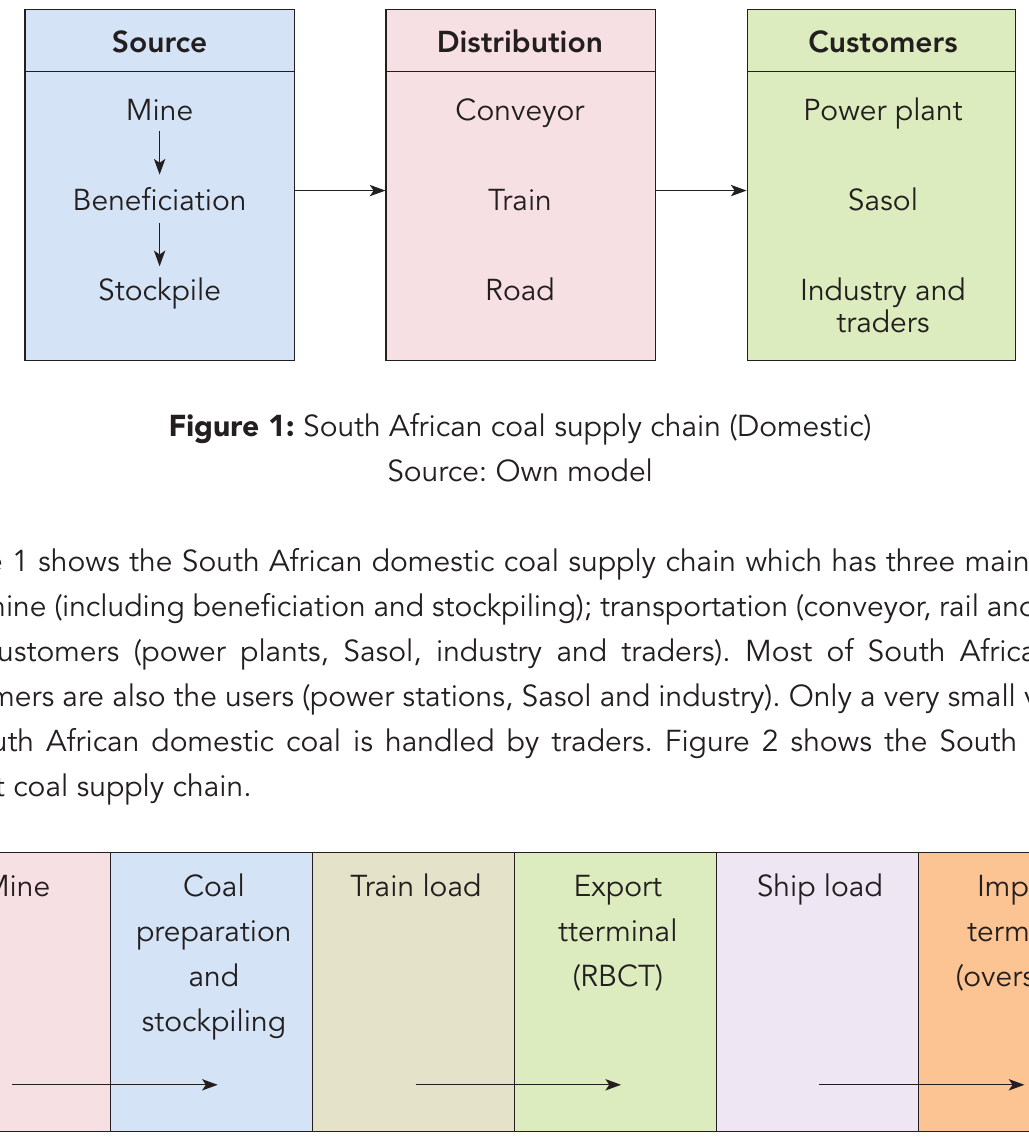
Figure 2: South African export coal supply chain Source: Own